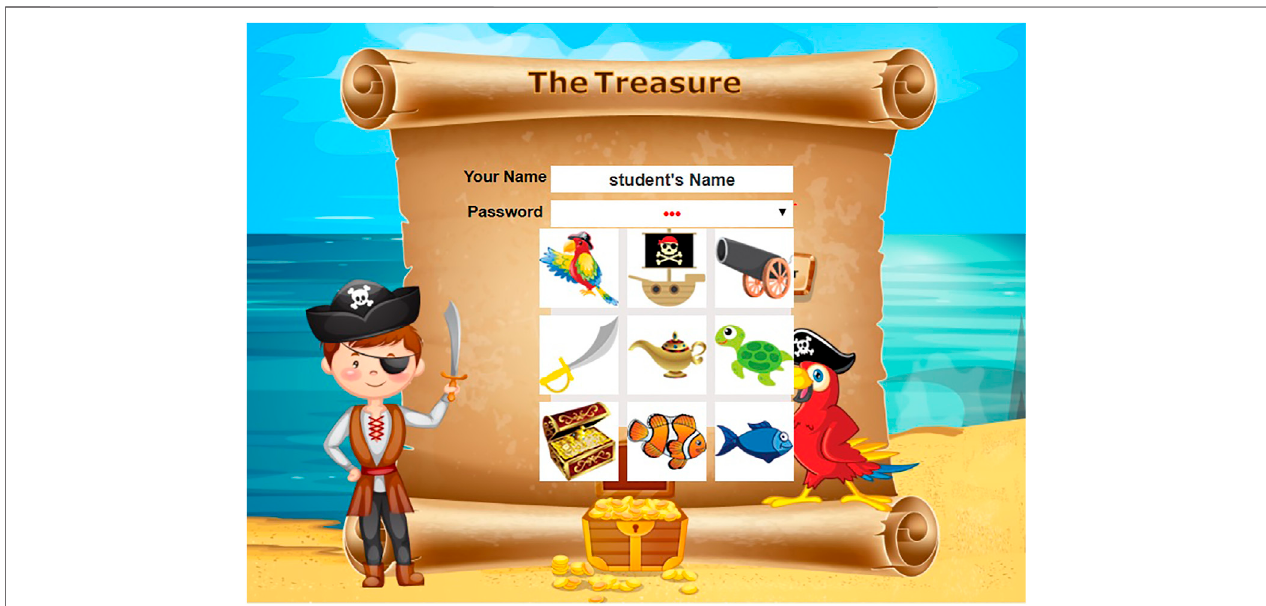
FIGURE 4 | Visual password consisting of nine images from which the user selects three images to form his own password.